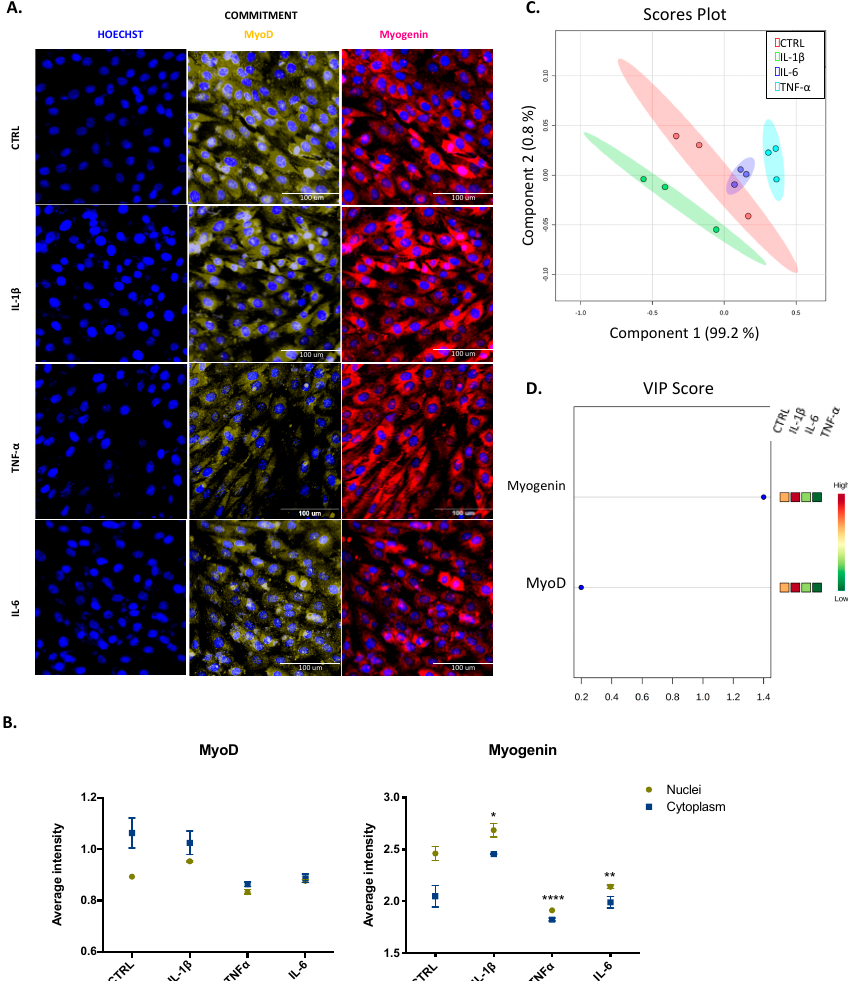
Figure 5. Transcription factor expression for C2C12 cells at the commitment stage. ( A ) Representative images of myogenic transcription factor expression obtained by HCS (scale bar: 100 µ M). ( B ) The average intensity in the nucleus (yellow) and cytoplasm (blue) of every factor at basal (CTRL) and treated conditions. ( C ) Principal component analysis (PCA) and partial least squares discriminant analysis (PL-SDA) score plots show the di ff erences and similarities between treatments IL-1 β (green), IL-6 (blue), and TNF- α (light blue) and the control (red). ( D ) VIP score indicates myogenin is the most relevant factor at this stage. Data are shown as mean ± SEM (* p < 0.05, ** p < 0.01, and **** p < 0.0001 vs. control from two-way ANOVA and Dunnett’s post-test; PCA and